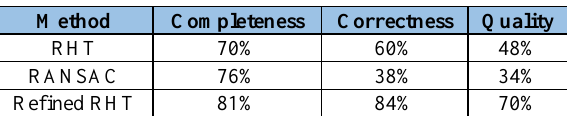
Table 2. Evaluation of the automatic extraction of the building roof planes.